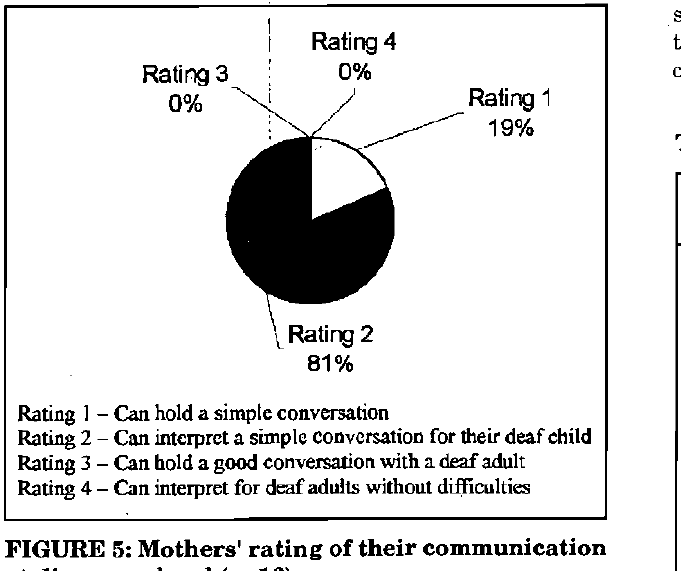
FIGURE 5: Mothers' rating of their communication at discourse level